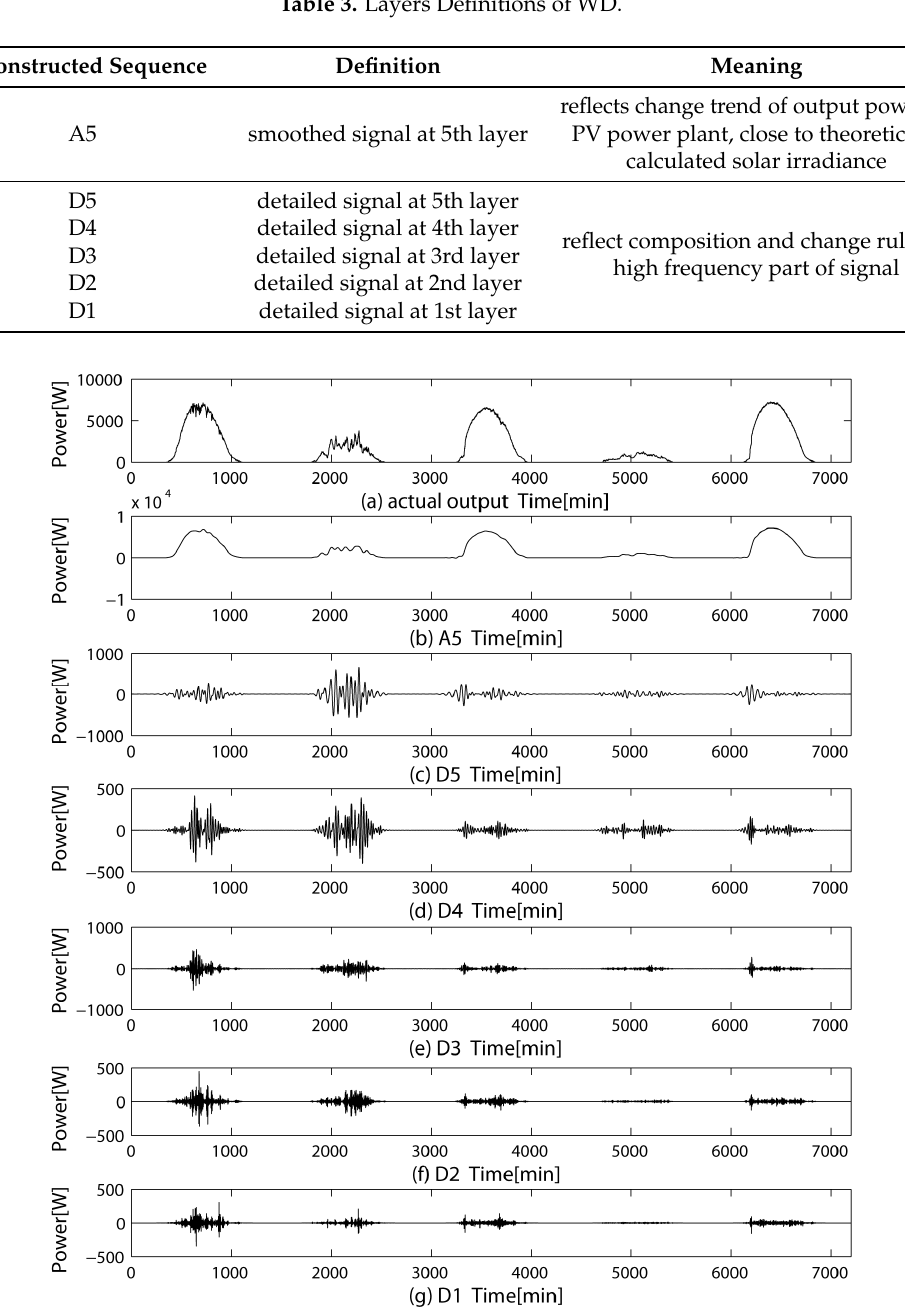
Figure 4. WD of PV output power. ( a ) Original signal of actual PV output, ( b ) Smoothed signal